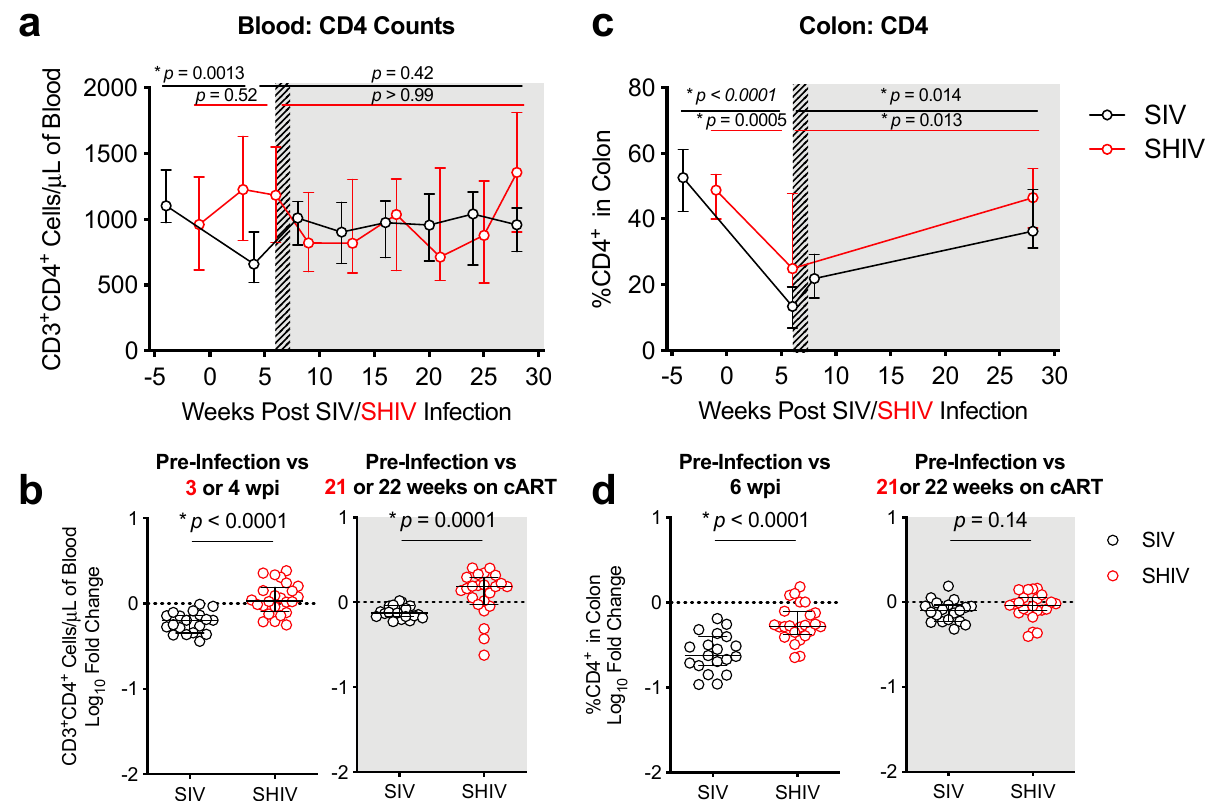
Figure 3. Peripheral and mucosal CD4 depletion in SIV-infected, but only mucosal depletion in SHIV-infected macaques. ( a ) CD4 + T-cells in the blood were quantified from the complete blood count (CBC) following flow cytometry analysis. ( c ) The frequency of CD4 + T-cells within the CD45 + T-cell subset from colon biopsies was determined by flow cytometry. ( a , c ) Hashed and shaded regions indicate periods of cART treatment for SIV RMs and all animals, respectively. Lines indicate medians with interquartile ranges. Kruskal–Wallis test, adjusted p -values are given. ( b , d ) Log 10 -fold change in CD4 T-cells between pre-infection and acute infection at 3 (SHIV) or 4 (SIV) weeks post-infection (wpi) or after 21 (SHIV) or 22 (SIV) weeks (>5 months) on cART in the blood ( b ) or colon ( d ) between SIV (black open circles) and SHIV (red open circles). Each dot represents an individual RM with medians and interquartile ranges indicated. The dotted line indicates no change (value of 1). p -values were determined using a Mann–Whitney test, with * p -values ≤ 0.05 considered significant.